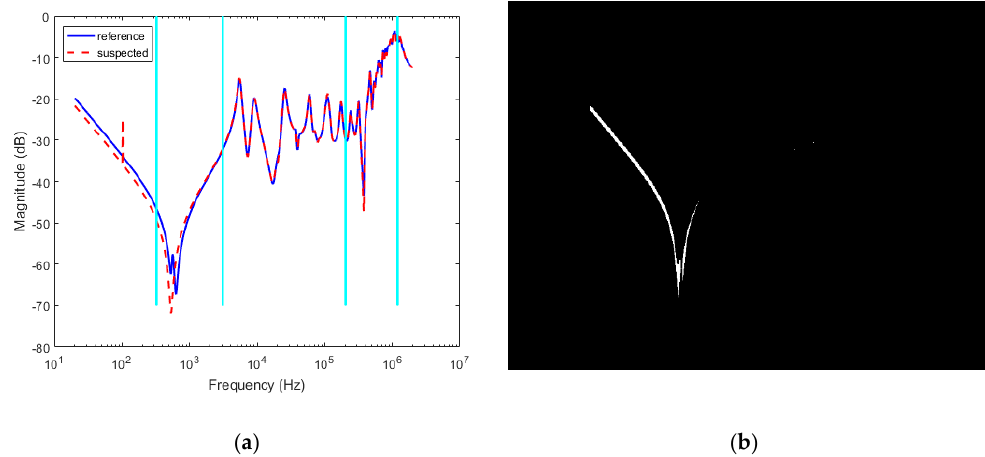
Figure 11. Results of Case 1 using the HDR classifier: ( a ) FR plot with boundaries of frequency sub-bands; ( b ) eroded binary image.